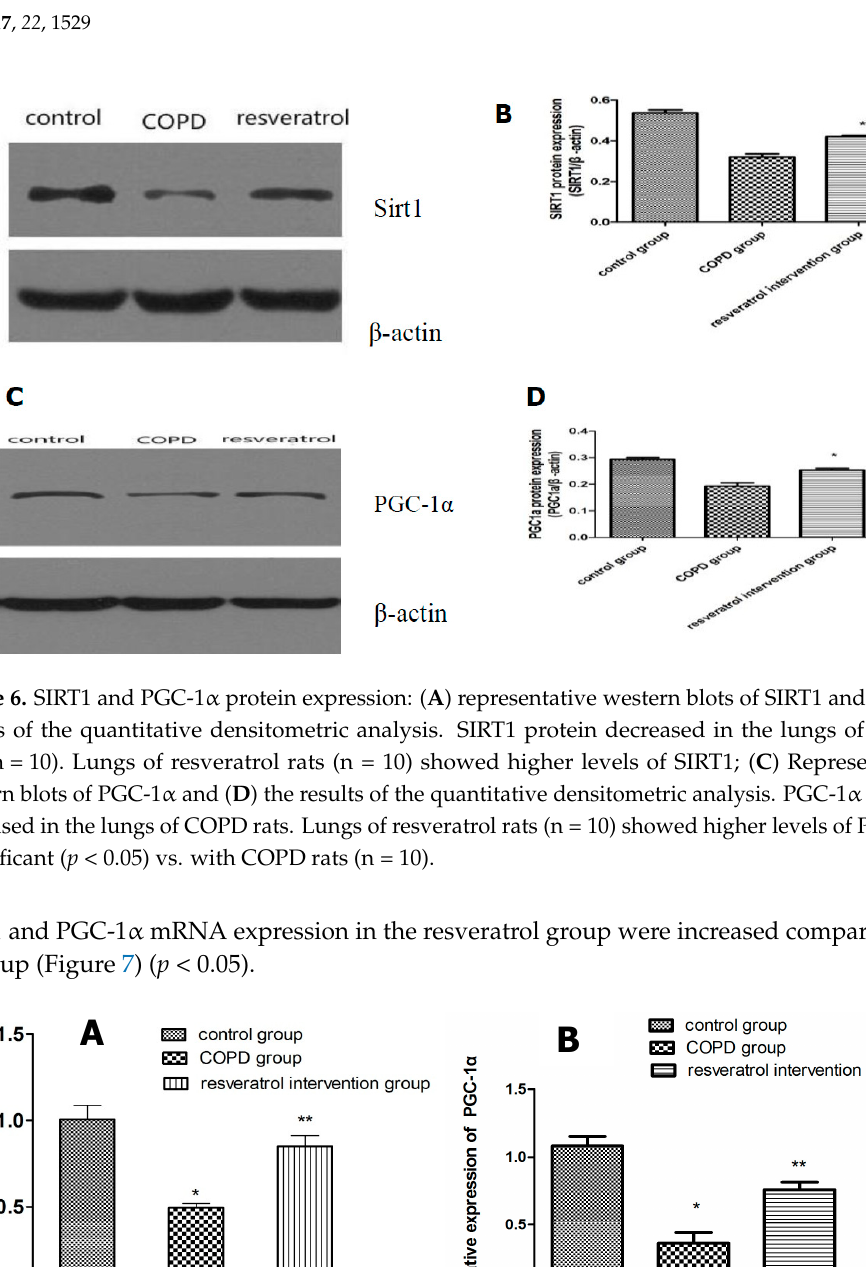
6 of 13 Figure 5. Expressions of SIRT1 and PGC-1 α in lung tissues in rats. ( A ) Expression of SIRT1 in lung